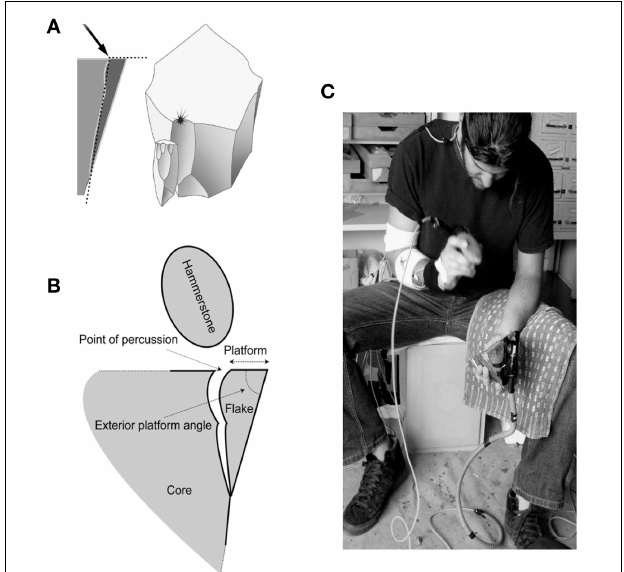
FIGURE 3 | The stone flaking process. (A) Conchoidal fracture results from an angle of percussion of approximately 40–50 ◦ and an exterior angle of approximately 70–80 ◦ (adapted from Pelegrin, 2005, with permission); (B) Terminology used to describe the mechanics of stone flaking. (adapted from Bril et al., 2012); (C) An expert subject in the process of removing a stone flake under experimental conditions. The core is positioned using the left hand while the strike is delivered using the hammerstone in the subjects right hand. Movement sensors can be seen on the subject’s arm as well as the working materials. This experiment analyzed movements from the highest position of the striking hand through to the completion of the